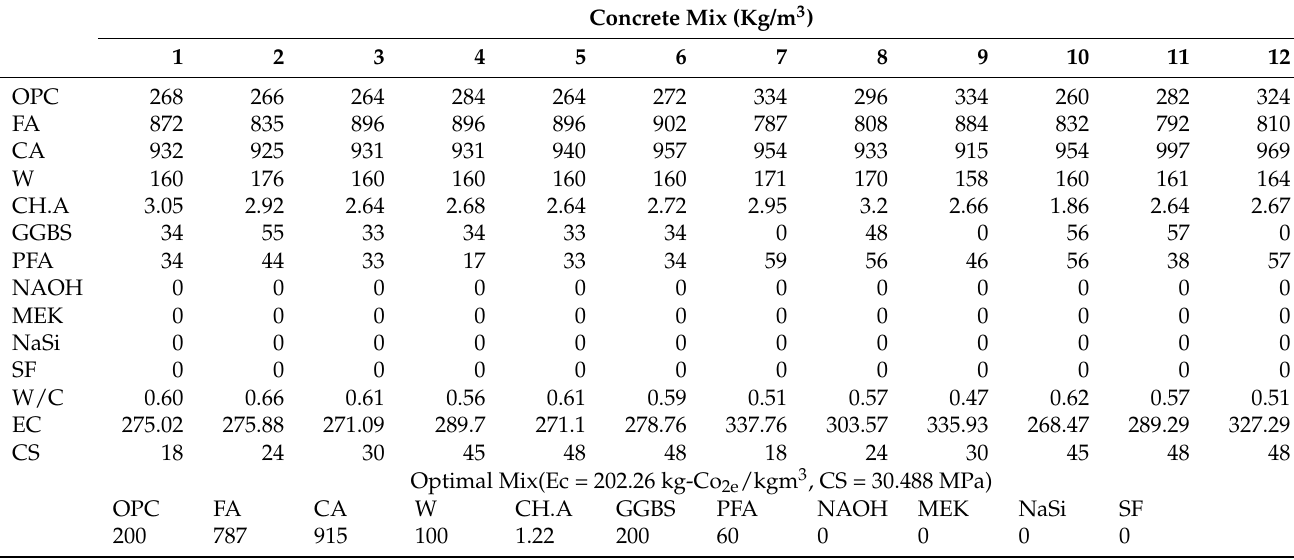
Table 13. Concrete mix optimisation extracted from Concrete Batch B [32].